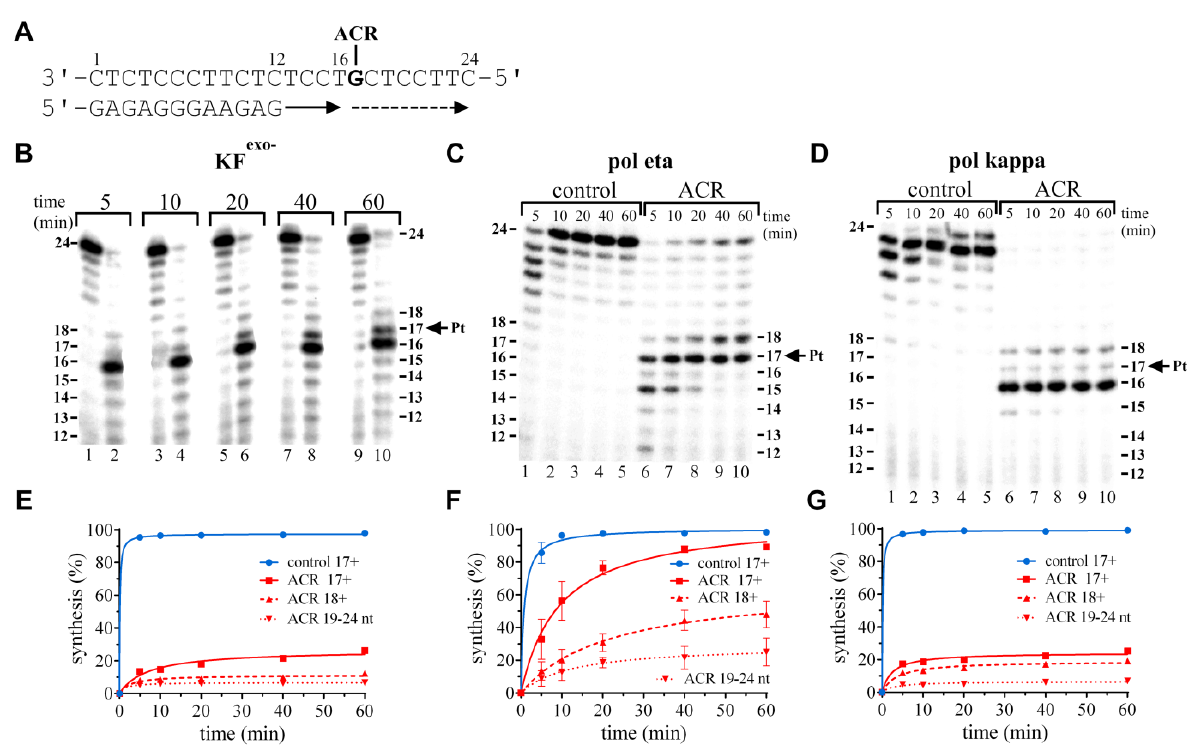
Figure 2. ( A ) “Running-start” translesion DNA synthesis by the exonuclease-deficient Klenow fragment of DNA polymerase I (KF exo − ), human DNA polymerases pol η and pol κ on the 12-mer/24-mer primer/templates containing a single site-specific adduct of ACR in the presence of all the four dNTPs. The sequence of the primer/template duplex and the position of the platinated guanine are shown in Figure 2A. Primer extension activities of KF exo − , pol η , and pol κ are shown in Figure 2B,E, Figure 2C,F and Figure 2D,G, respectively. ( B – D ) Representative images of the DNA polymerase reaction products resolved on 15% polyacrylamide (PAA) gels. The experiments were conducted for various time intervals (5–60 min; shown above the gels) using the undamaged template (panel B , lanes 1, 3, 5, 7, 9; panels C , D , lanes marked as the control) and the template containing the ACR adduct (panel B , lanes 2, 4, 6, 8, 10; panels C , D , lanes marked as ACR). The pause sites and the position of the platinated guanine (intermediate lengths) are shown on the right or left side of the gels. ( E – G ) Densitometric evaluations of the intermediate accumulation during synthesis past the undamaged or modified template. Control 17+ and ACR 17+, translesion synthesis past and behind the position of the adduct on the undamaged (control) template (blue circles and the solid line), the template containing ACR (red squares and the solid line); ACR 18+, synthesis behind the ACR adduct (red triangles and the dashed line); ACR 19–24 nt, accumulation of “full-length” nucleotide (nt) products behind the ACR adduct (red inverted triangles and the dotted line). The data are the means (± SEM) from three different experiments.